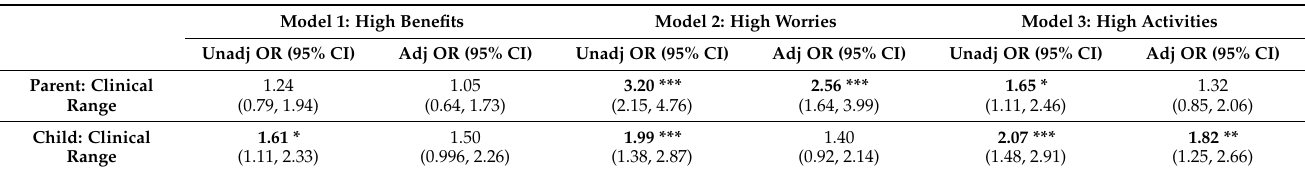
Table 5. Unadjusted and adjusted logistic regression models examining associations between poor parent and child mental health and high ratings of pet benefits, worries and